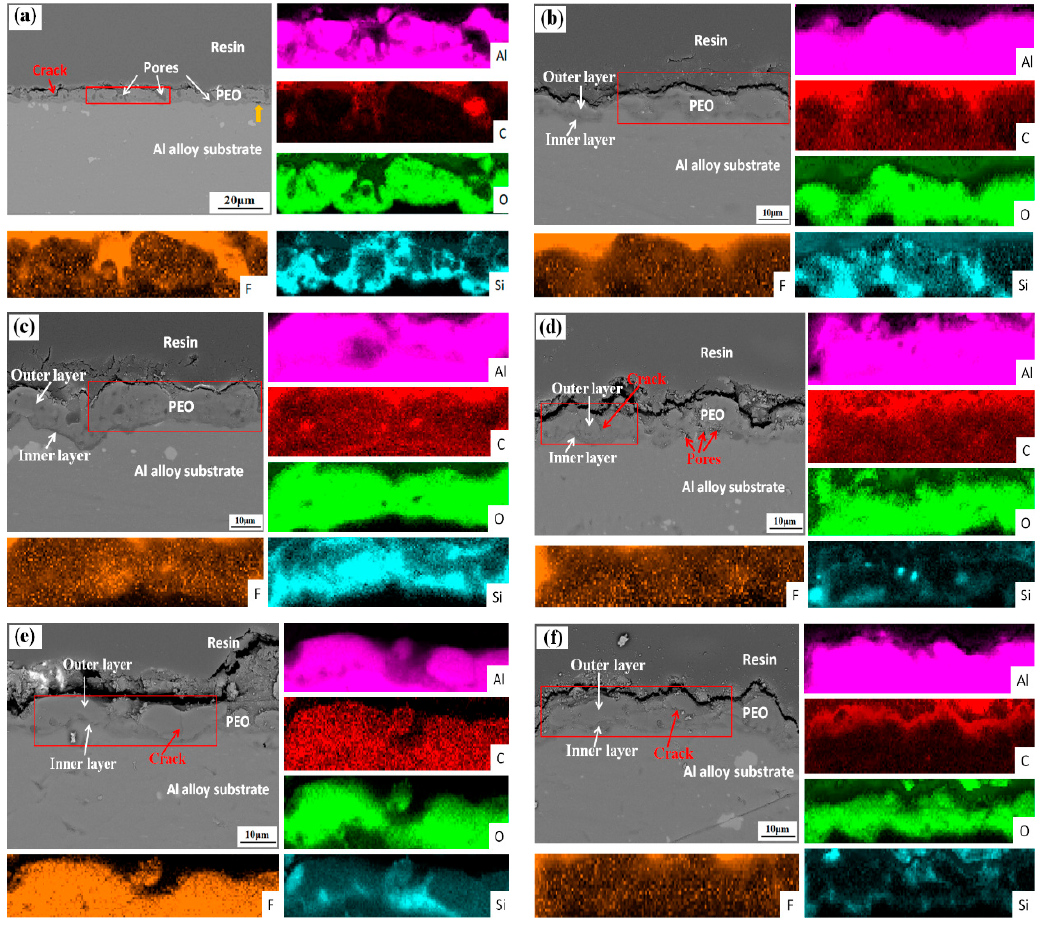
Figure 5. The thickness of coated samples with different concentration graphene.